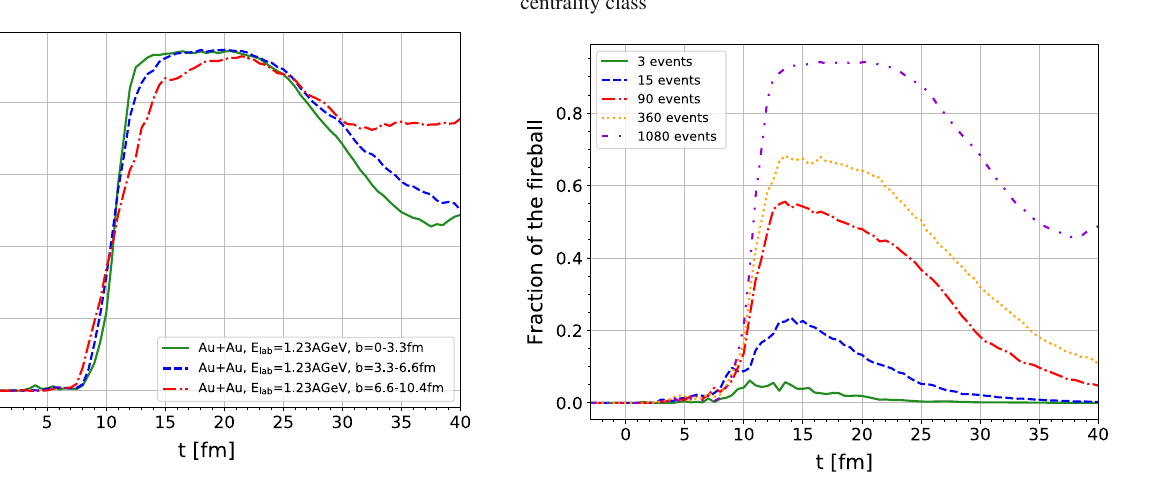
Fig. 16 Time evolution of the average fraction of the system sat- isfying the conditions X < 0 . 3, Y < 0 . 3, ε > 1 MeV / fm 3 for C+C at E lab = 2 AGeV, Ag+Ag at E lab = 1.58 AGeV, Ar+KCl at E